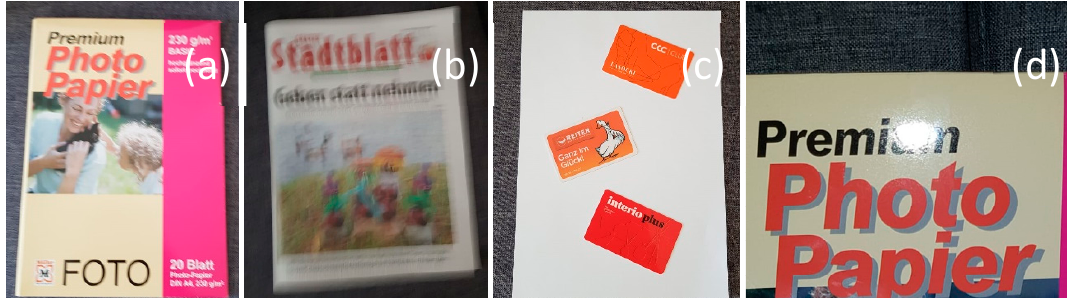
Figure 2. Main problems that can be encountered in document images: ( a ) Showing a document photo is usually taken from a mobile phone; ( b ) Showing a document image with motion blur; ( c ) Example of a document image delivering multiple documents within one single image shot; and ( d ) Example of a document image with a spotlight, which is blocking/disturbing reading the content. (Source: our own pictures).